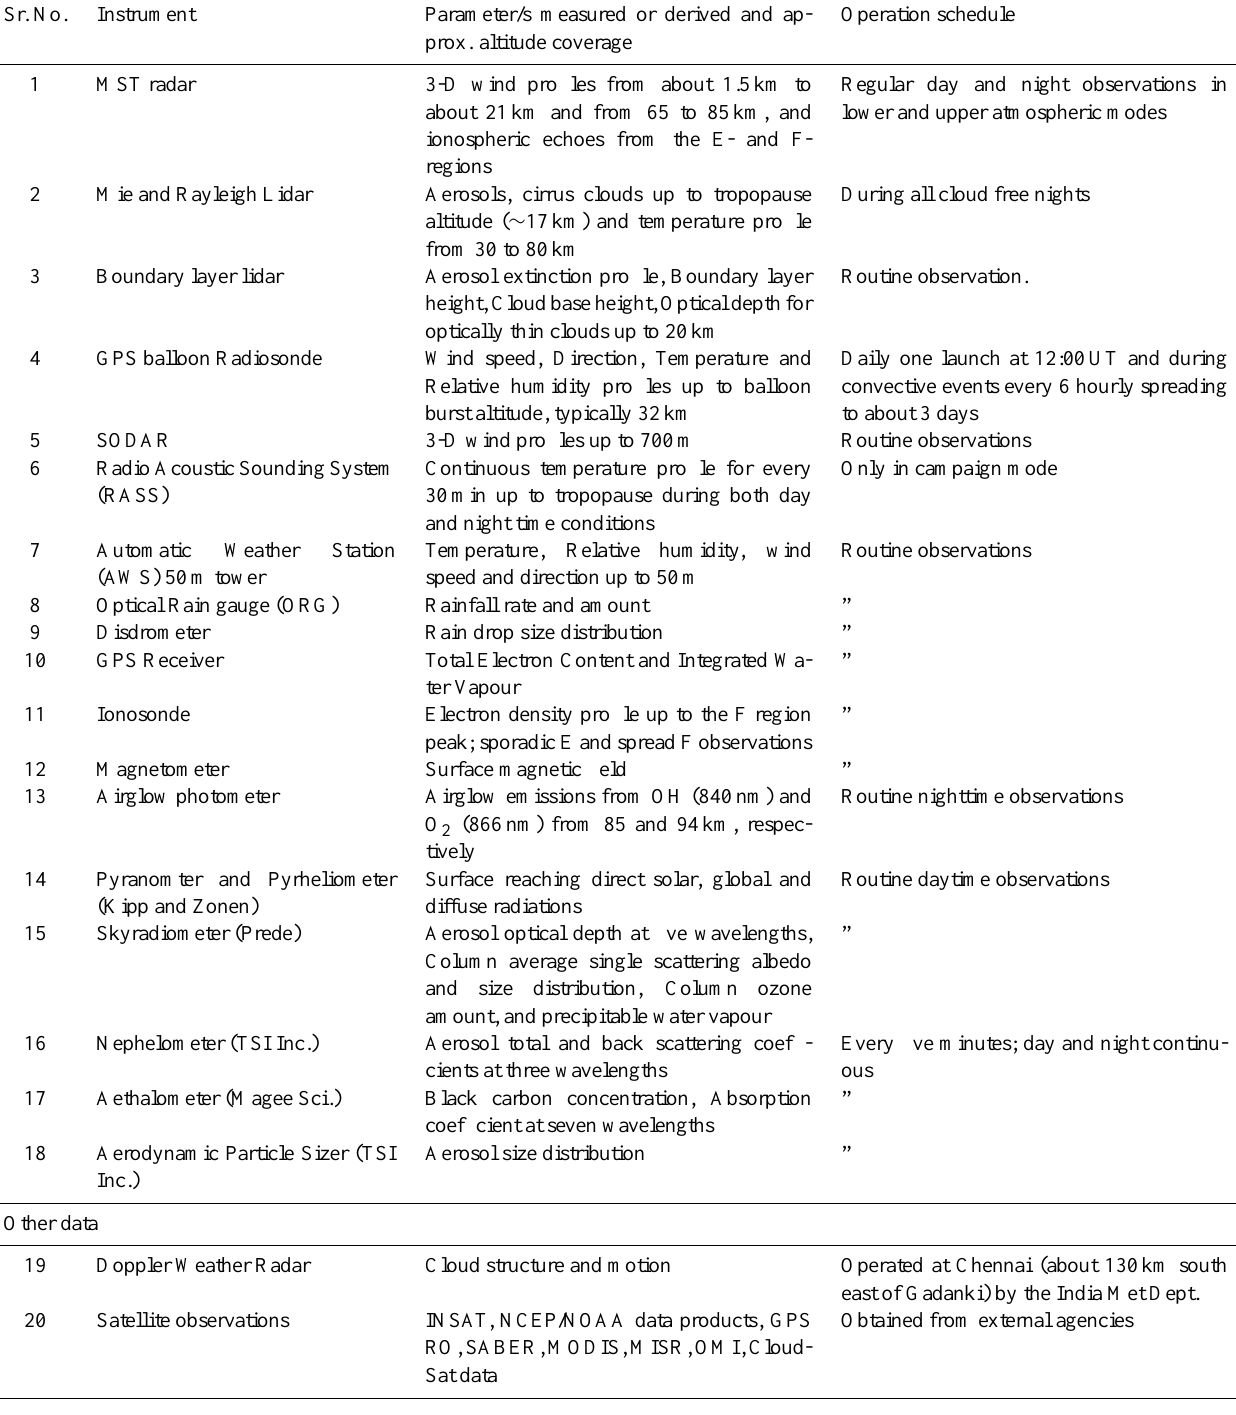
Table 1. List of instruments with complementary techniques currently available at NARL, Gadanki, a tropical site in India to study the entire column of the earth’s atmosphere as part of the SAFAR main campaign. Sr.